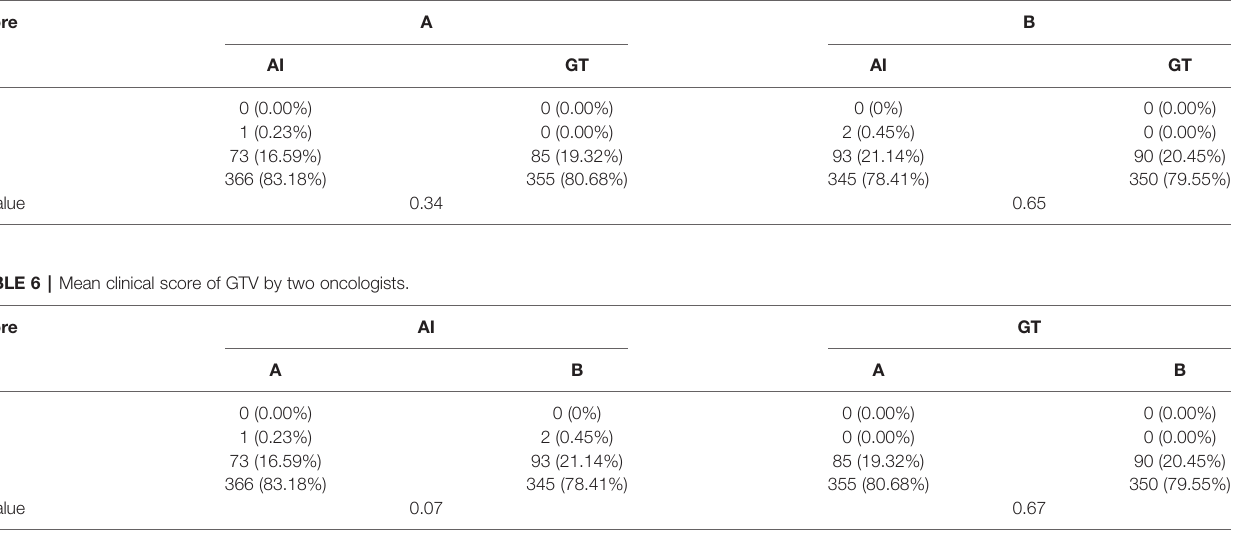
TABLE 5 | The oncologists ’ evaluation results.